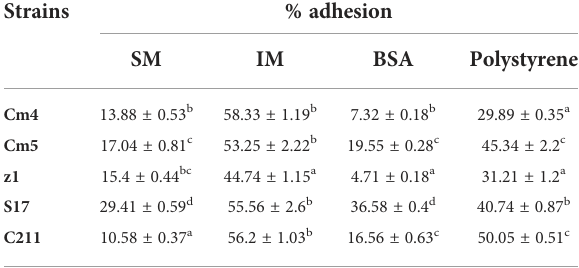
TABLE 5 Adhesion of selected strains to fi sh mucus.